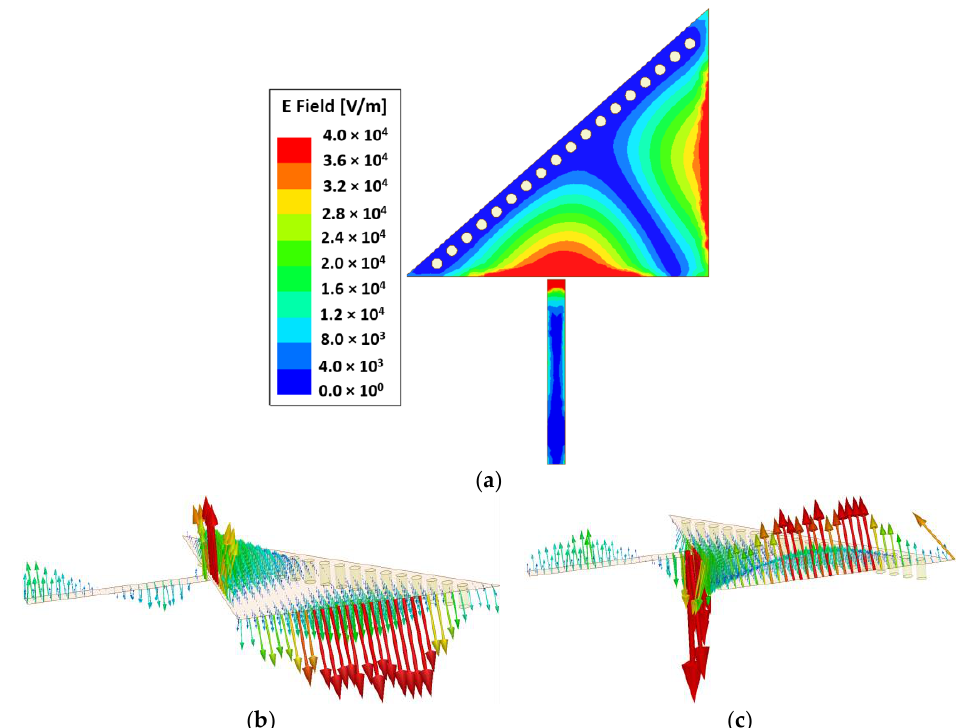
Figure 4. ( a ) E-field magnitude of the proposed TM 02 -mode QMSIW resonator at the resonance frequency of 5.81 GHz. Two distinct strong E-field regions are the best place to load two microfluidic channels. E-field vectors (vertical distribution) of the proposed TM 02 -mode QMSIW resonator during ( b ) a positive half cycle and ( c ) a negative half cycle are shown. There is a clear distinction between the two strong E-field regions, as shown in ( a , b ). This ensures the realization of two closely spaced yet noninterfering channels.